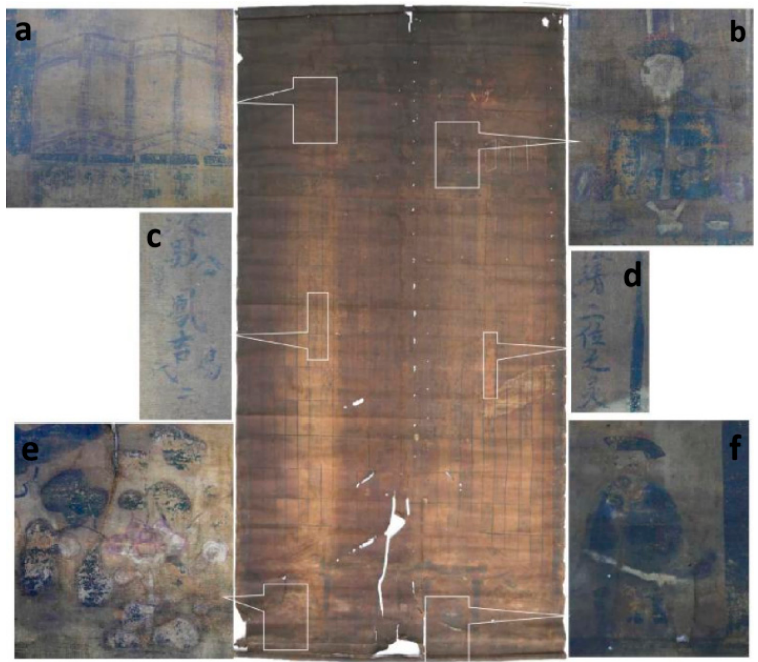
Figure 1. Pictures of the Jiatang scroll painting. ( a ) Domestic instrument; ( b , f ) ancestral portraits; ( c , d ) ancestor names; ( e ) flowers.